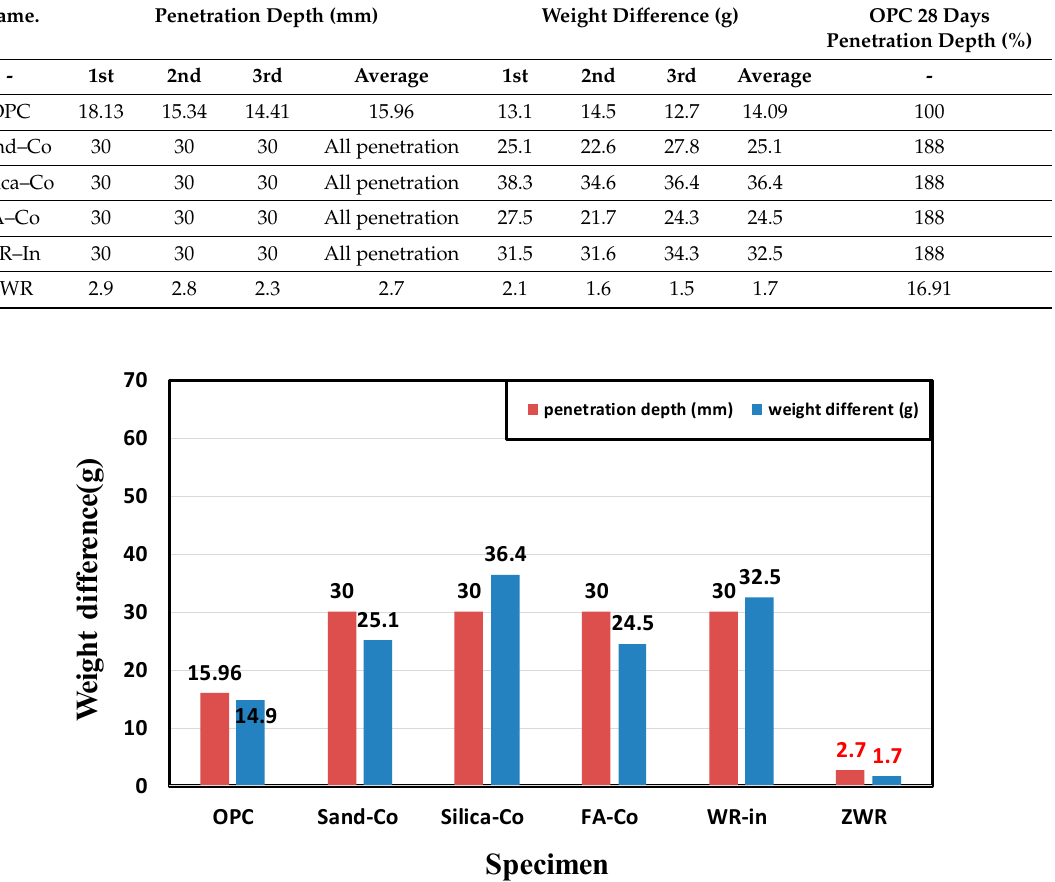
Figure 10. Result of water penetration test graph.